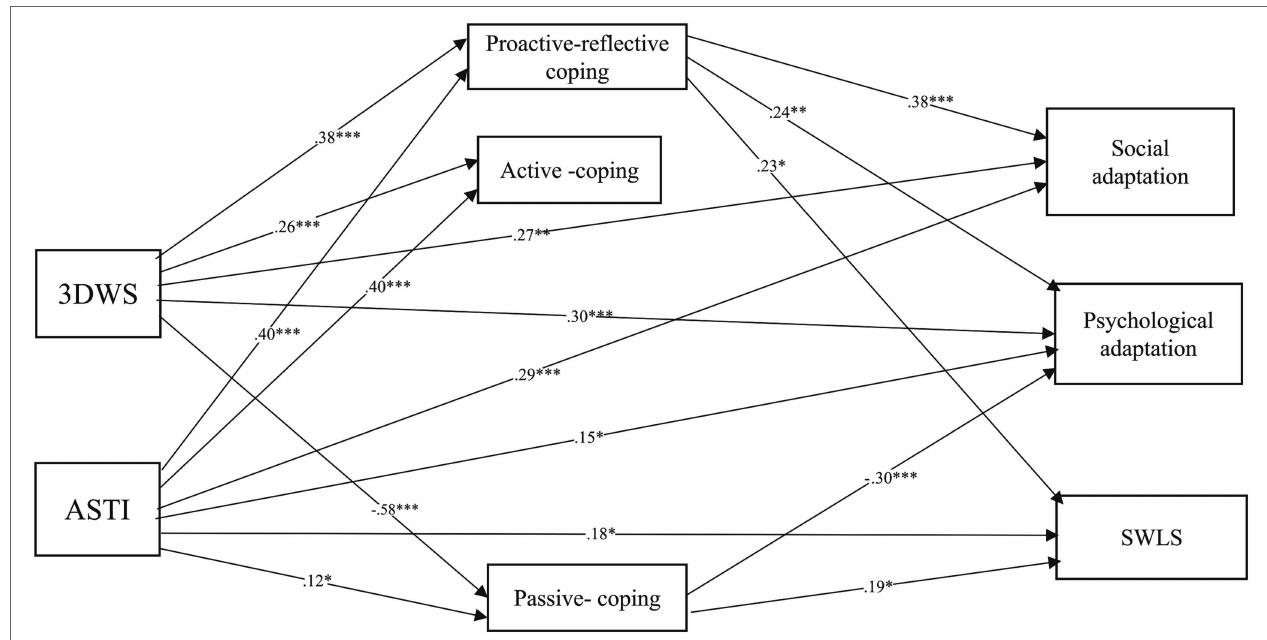
FIGURE 1 | Standardized parameter estimates of the effects of wisdom [3DWS and Adult Self-Transcendence Inventory (ASTI)] on adaptation and SWLS mediated by coping styles. N = 181, Model fit: χ 2 = 14.73, df = 11, χ 2 /df = 1.34, CFI = 0.99, TLI = 0.97, root mean square error of approximation (RMSEA) = 0.04, root mean